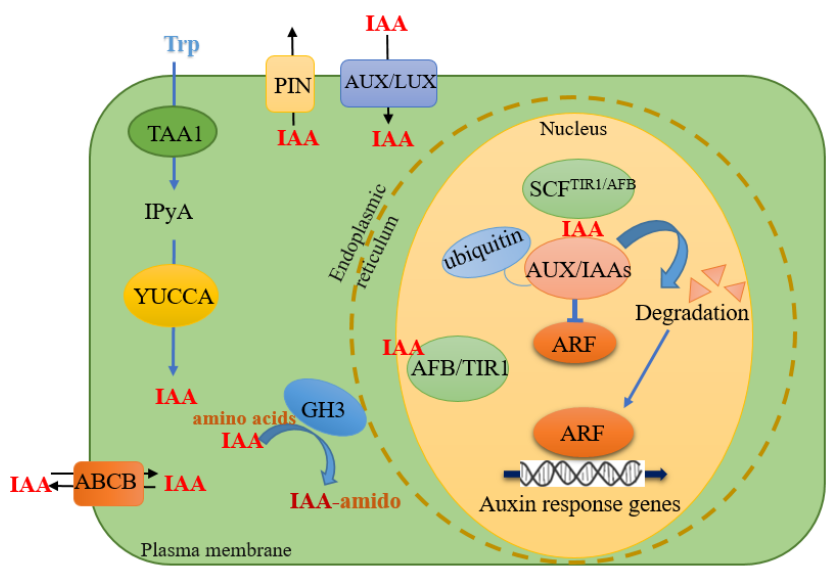
Figure 1. An abbreviated cellular model of auxin biosynthesis, transport, and signaling. IAA is biosynthesized from Trp via IPyA by TAA1 and YUCCA in the TAA/YUC pathway. IAA is transported by AUX1/LAX1, PIN, and ABCB proteins. The auxin-induced GH3 enzyme converts active IAA to inactive IAA-amido. Auxin induces ubiquitination and degradation of Aux/IAA proteins via SCF TIR1/AFB . Degradation of the Aux/IAA repressor recovers ARF activity to activate transcription of auxin-responsive genes.